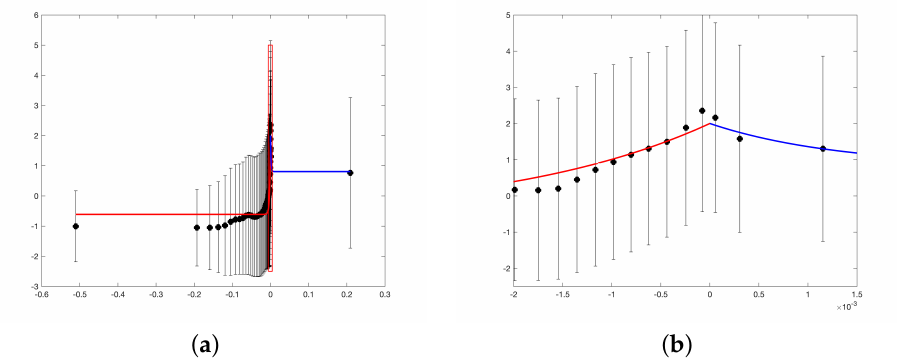
Figure 5. One-dimensional dependence of the value log K viation of average values for each interval from the average for the cluster when divided into 50 intervals with an equal number of cluster elements (horizontal value in kg/m 4 ); ( b ) an enlarged view of the group of dots in a rectangle shown in ( a ). Panels contain the closest curves for negative and positive values of the argument (red and blue solid lines). The vertical bars show the standard deviation for each